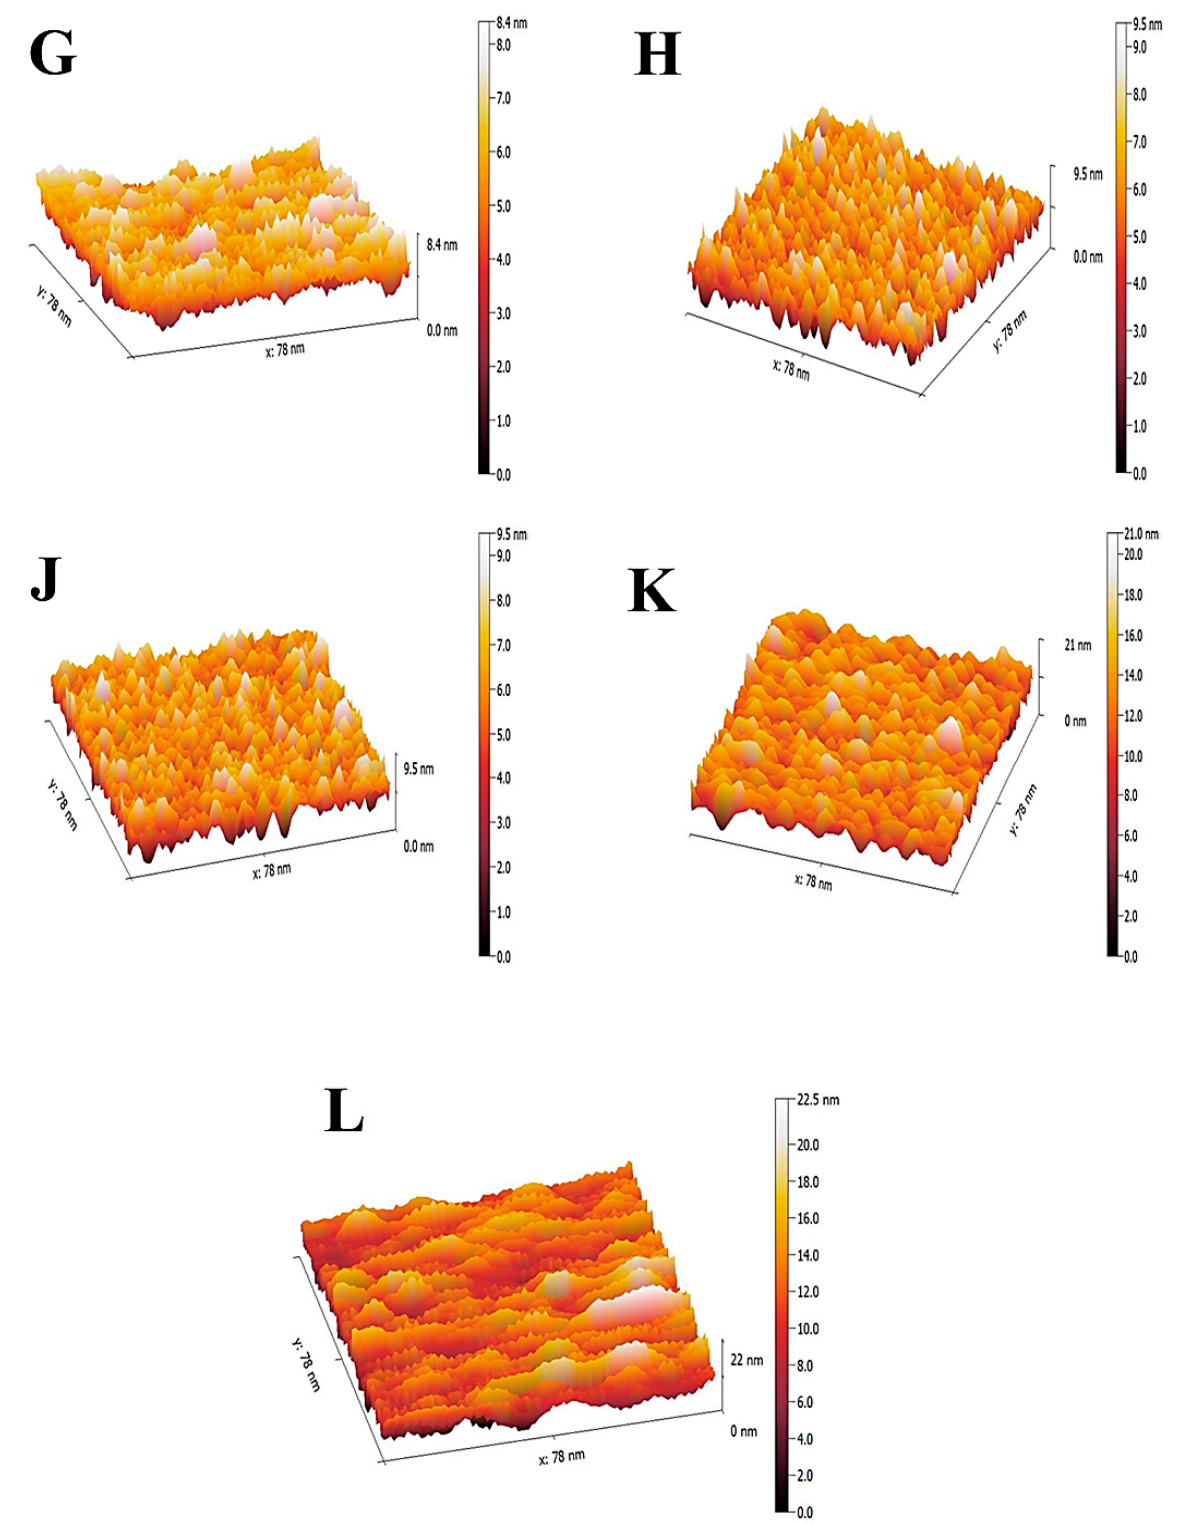
Figure 7. AFM surface topography images for ( A ) pristine, ( B ) 0.25 g, ( C ) 0.5, ( D ) 0.75 g, ( E ) 1 g, ( F ) 1.25 g, ( G ) 1.5 g, ( H )1.75 g, ( J ) 2 g, ( K ) 2.25 g, and ( L ) 2.5 g PMG-modified Table 3. Roughness parameters of the control and PMG ‐ modified membranes.